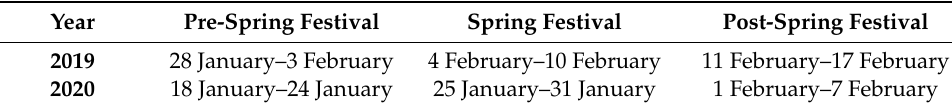
Table 4. Spring festival study period for 2019 and 2020.